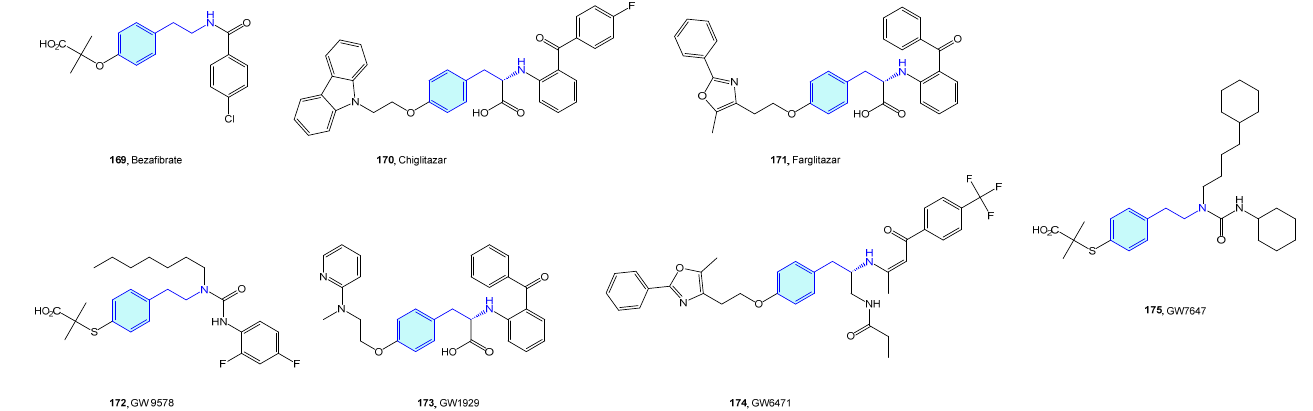
Figure 20. 2-Phenethylamines with 5-HT receptor activity. 2.15. Peroxisome Proliferator-Activated (PPAR) Receptors Peroxisome proliferator-activated (PPAR) receptors are peroxisome receptors and subcellular organelles performing several tasks related to cholesterol and fatty acid me- tabolism. Three members, named PPAR- α , PPAR- δ , and PPAR- γ , form this family, with different levels of expression and functionalities in diverse tissues, from energy storage in endothelial and vascular smooth muscle cells (type γ ) to energy expenditure across all bodies (type δ ). Several agents have been developed in relation to PPAR to address obe- sity, inflammation or neurodegenerative disorders (Figure 21, Table 8) [233,234]. Table 8. PPAR medicinal chemistry leads.